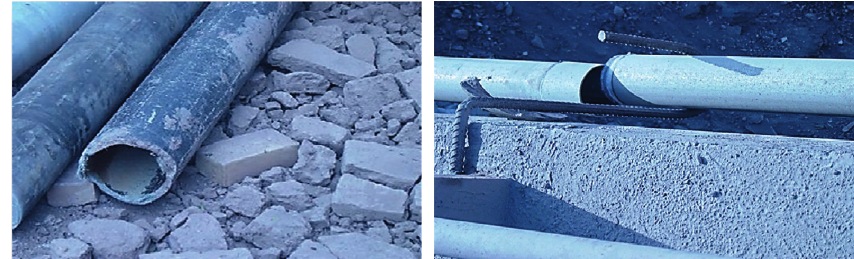
Figure 4: Damage occurred from Manjil earthquake.